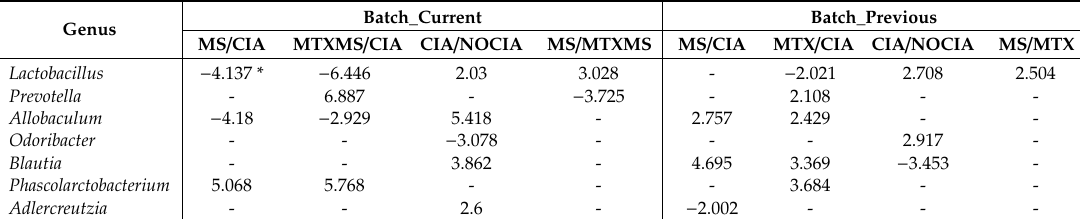
Table A1. Di ff erential genera in GI-PBMC integration in our previous experiment (batch1, [16]) and in the current batch (batch2), highlighted from Data